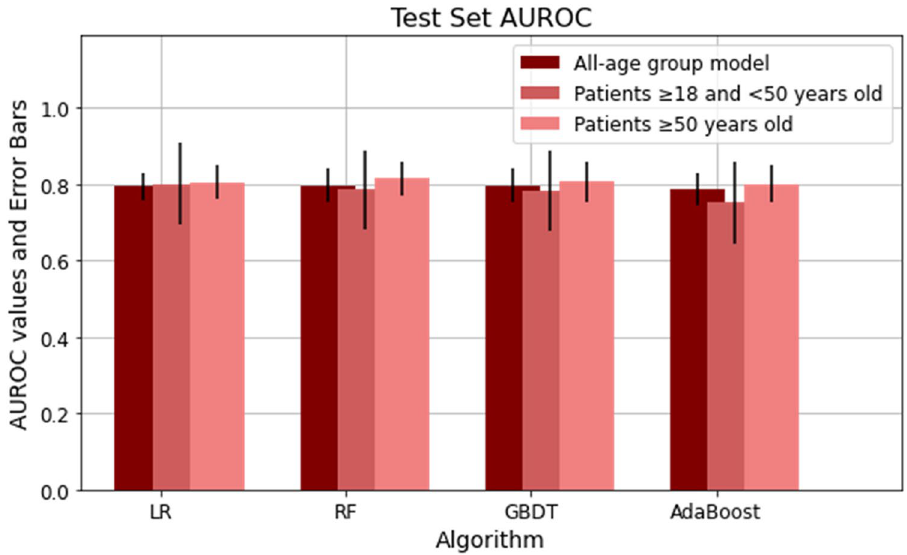
Figure 1. Area under receiver operator characteristic curve (AUROC) for age-stratified models of severe COVID-19 outcomes in hospitalized